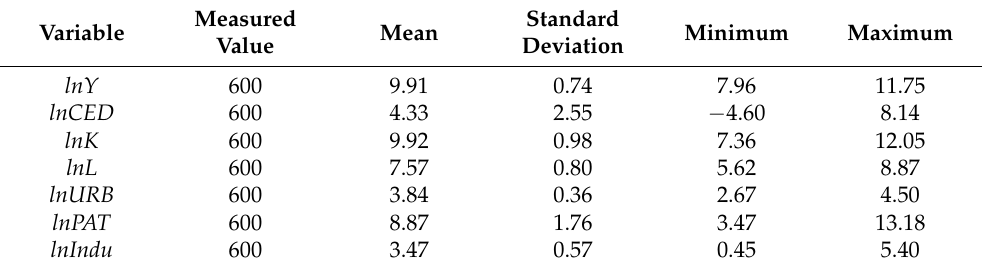
Table 2. Statistical description of the main